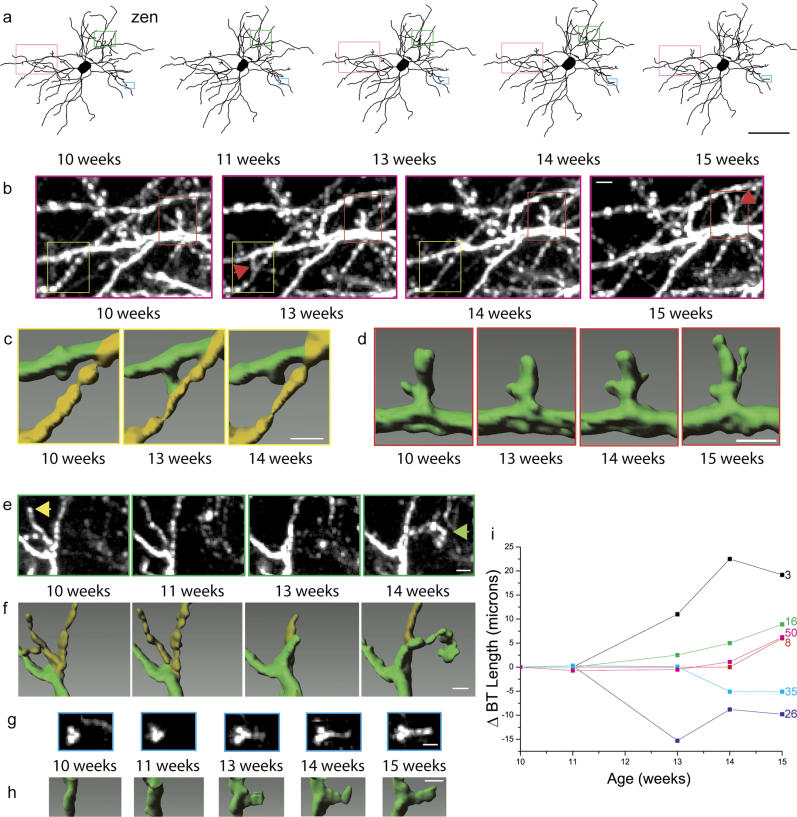
Branch Extensions, Retractions, and De Novo Branch Tip Addition in a Non-Pyramidal Neuron(A) Three-dimensional skeletal reconstructions of the sparsely spinous non-pyramidal neuron “zen” from images acquired over 5 wk.(B) High-magnification MZP view of region outlined by purple box in (A). Red arrowheads indicate examples of structural remodeling. Three-dimensional isosurface reconstructions show(C), the elongation and retraction of a spine toward an axon (yellow overlay).(D) Structural change in a cluster of branch tips (#50, far right) (red box in [B]).(E) Higher-magnification MZP view of region outlined by green box in (A). Examples of process retraction and branch-tip (#3) addition are labeled with yellow and green arrowheads, respectively.(F) Three-dimensional isosurface reconstructions of (E) with axon in yellow overlay.(G) MZP view of region outlined by cyan box in (A) shows branch-tip (#16) addition on a different dendrite.(H) Three-dimensional isosurface reconstructions of (G).(I) Plot of change in BTL of dynamic branch tips as a function of age. Number to the right denotes branch tip number.Scale bars: (A), 50 μm; (B–H), 5 μm.